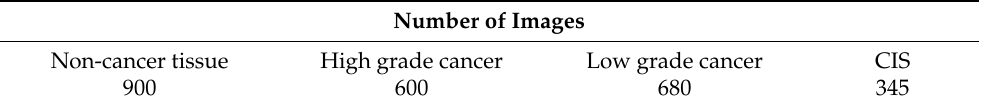
Table 3. Number of instances in all four classes used in the presented research.